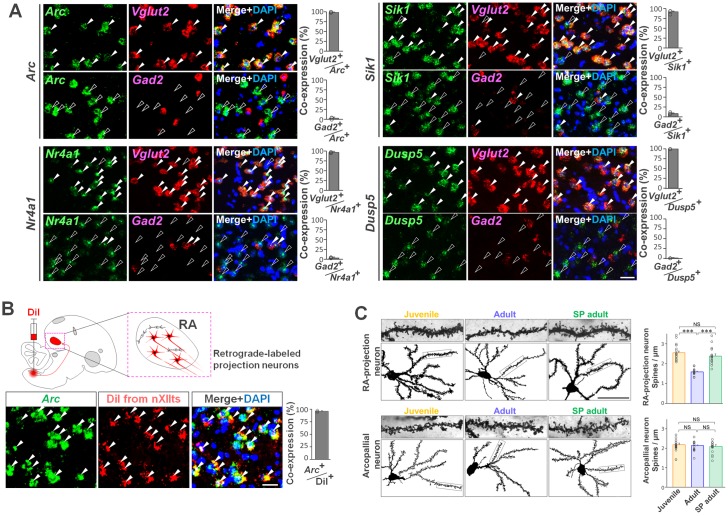
Singing experience–mediated dendritic spine pruning in RA projection neurons.(A) Coinduction of RA cluster I genes (Arc, Nr4a1, Sik1, and Dusp5) after juvenile singing in glutamatergic neurons with Vglut2 (+) but not GABAergic neurons with Gad2 (+). Filled and empty arrowheads: cells that coexpressed or did not coexpress with singing activity–dependent genes and cell marker genes, respectively. Cell nuclei (blue, DAPI). Scale bar = 40 μm. Bar graphs: proportion of each subpopulation in cells that express the mRNA of RA Cluster I genes. (B) Selective induction of Arc mRNA (green) after juvenile singing in RA projection neurons. Diagram of DiI retrograde labeling (red) of RA projection neurons to nXIIts. Cell nuclei (blue, DAPI). (C) Golgi-stained RA projection neurons and RA-surrounding arcopallial neurons in juvenile (55 phd), adult (105 phd), and SP adult (101 phd at 1–2 days after release) birds. Scale bars = 5 μm (upper) and 50 μm (lower). Bar graphs: dendritic spine density of RA projection neurons and RA-surrounding arcopallial neurons in juveniles (n = 18 cells from 6 birds), adults (n = 15 cells from 5 birds), and SP adults. ***P < 0.0001, NS: p > 0, unpaired t test with Bonferroni correction. Error bars: SEM. Supporting data can be found in S5 Data. NS, not significant; phd, post hatching day; RA, robust nucleus of the arcopallium; SP, singing-prevented.